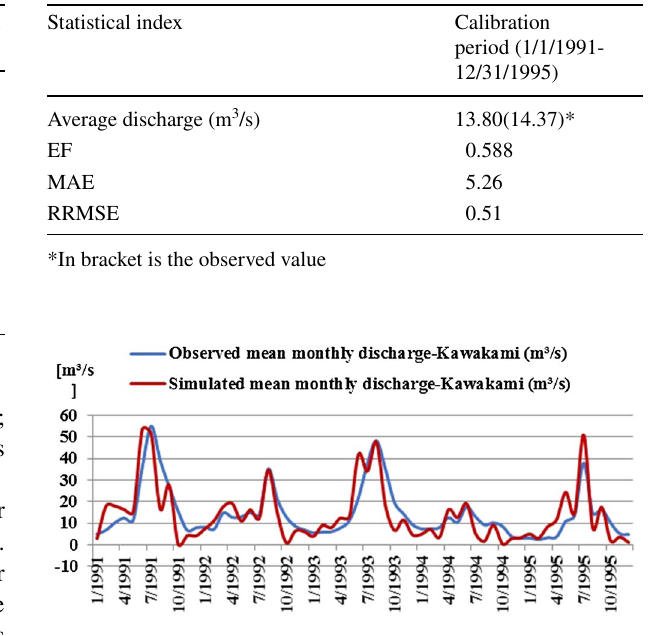
Fig. 5 Observed and simulated hydrographs at Kawakami